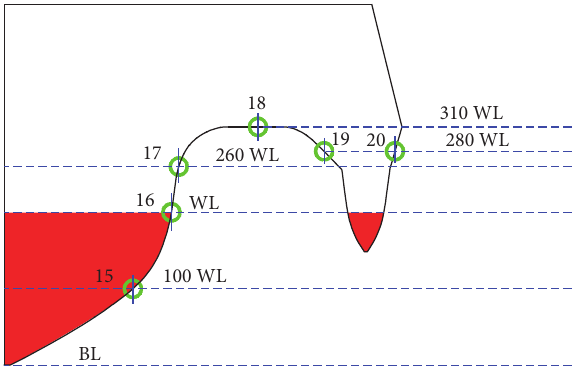
Figure 7: Pressure gauges arrangement at stern.